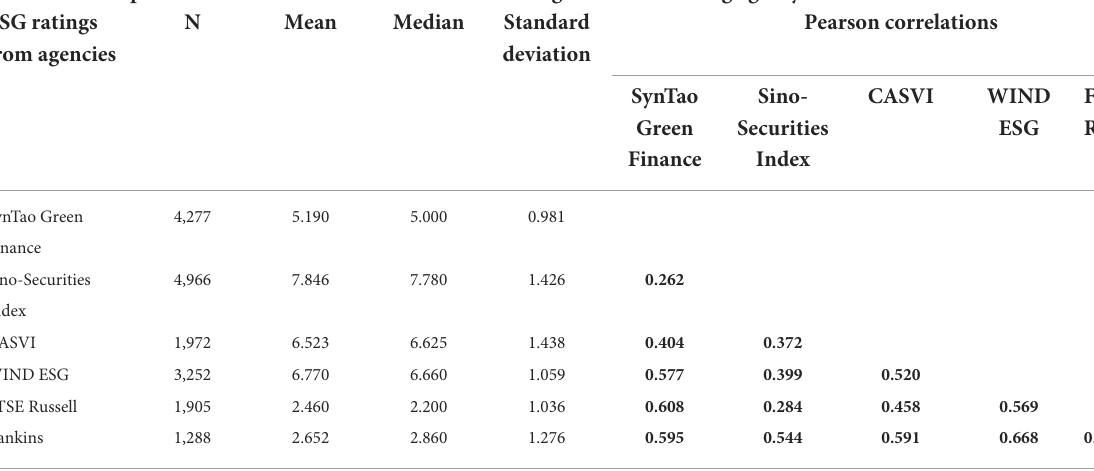
TABLE 2 Descriptive statistics. Panel A: Descriptive statistics and correlations for ESG ratings from each rating agency ESG ratings